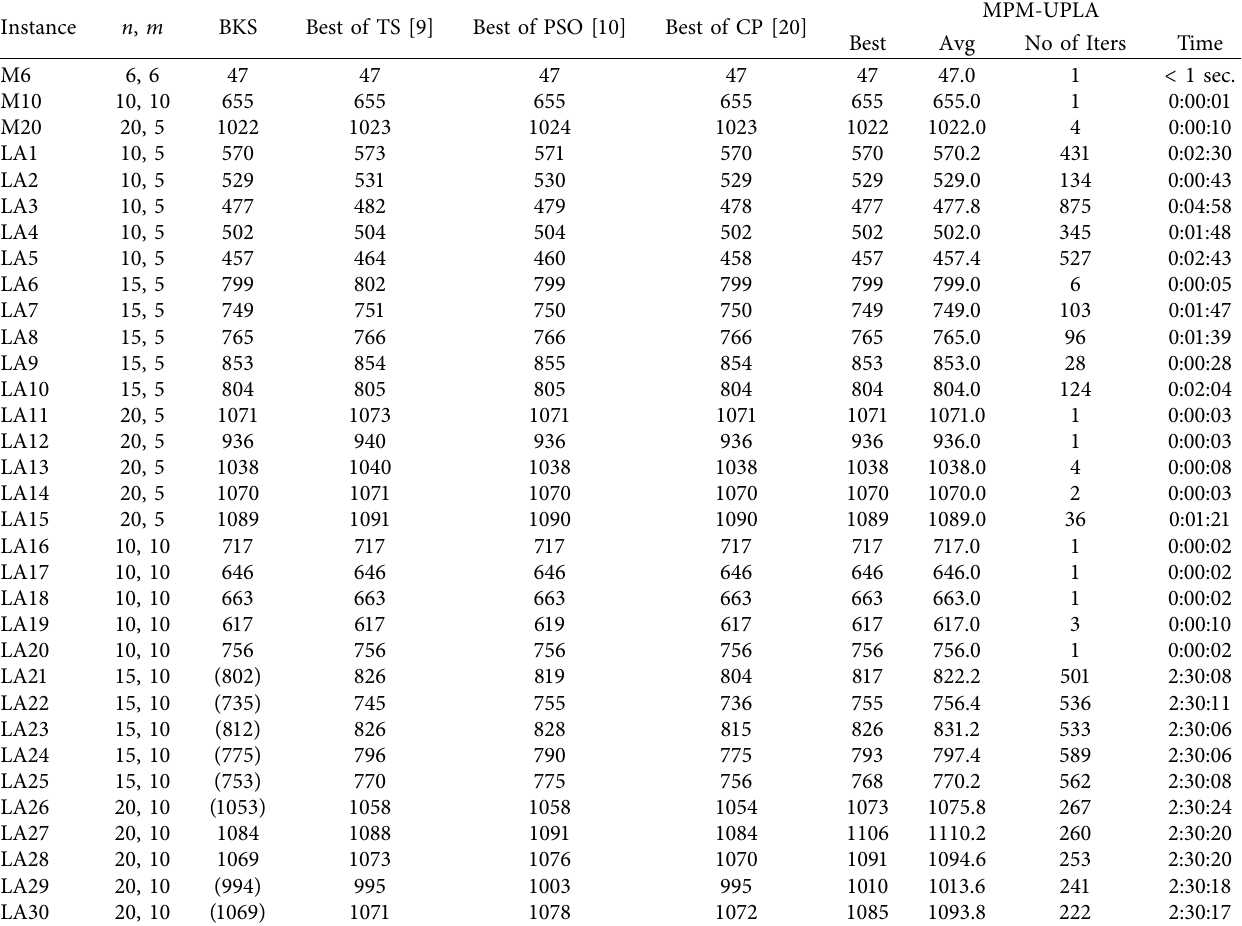
Table 3: Results on